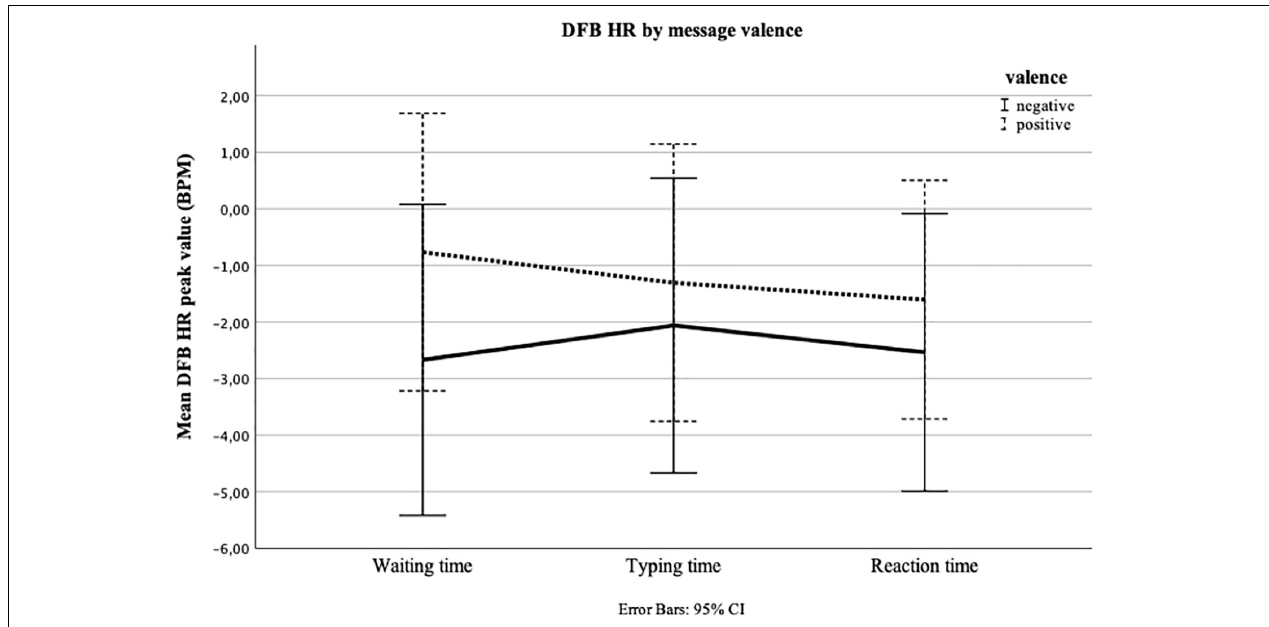
FIGURE 5 | Repeated measures of heart rate (HR) in beats per minute (BPM) for Waiting time, Typing time, and Reaction time by message valence (positive = positive answer from peer; negative = negative answer from peer). The y -axis shows the mean peak value calculated as a deviation from the baseline measure (DFB) for the final 30 s of Waiting time, the first 30 s of Typing time, and the first 30 s of Reaction time.